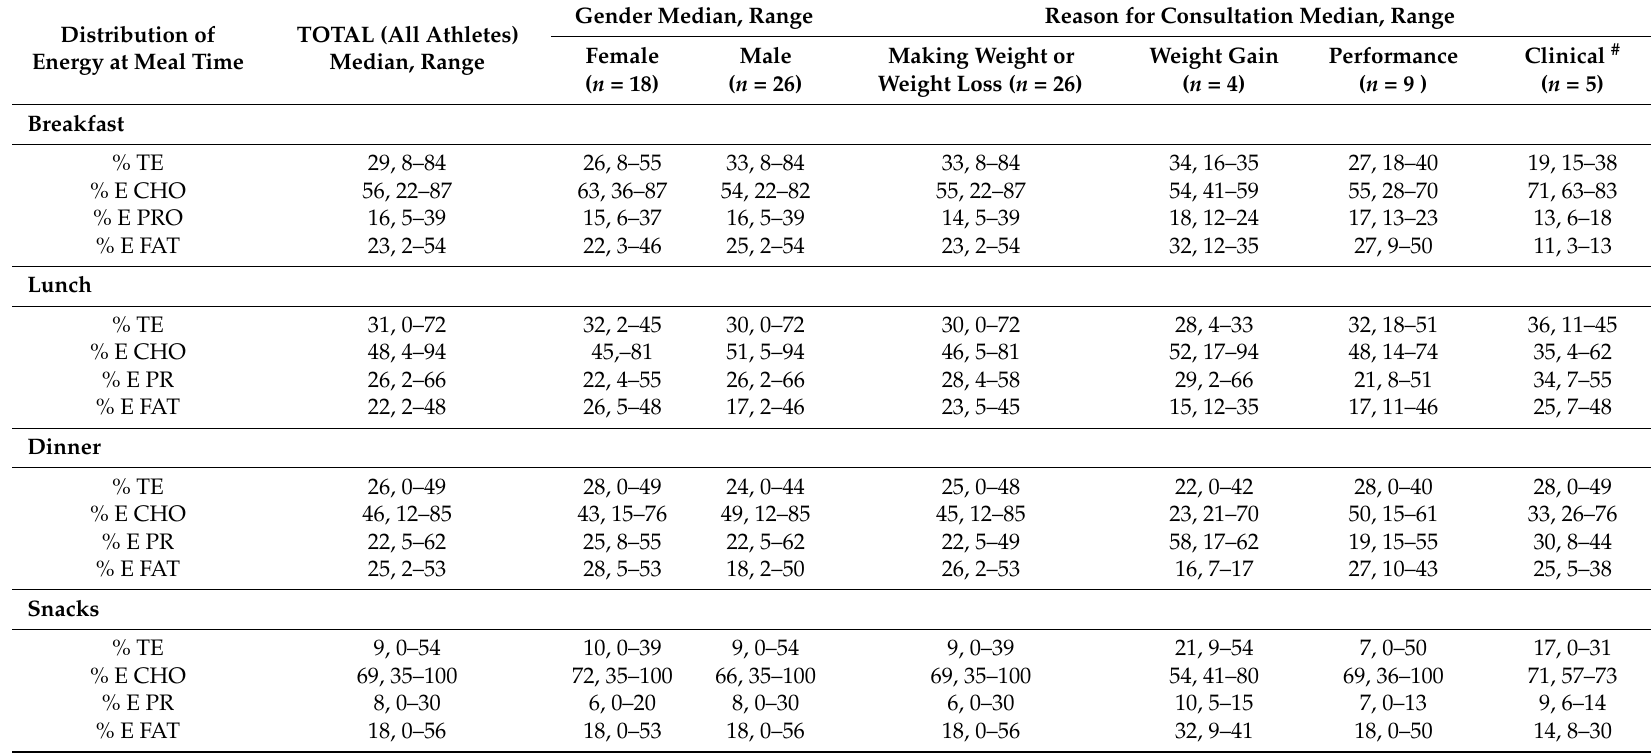
Table 3. Distribution of energy and macronutrient contribution at meal